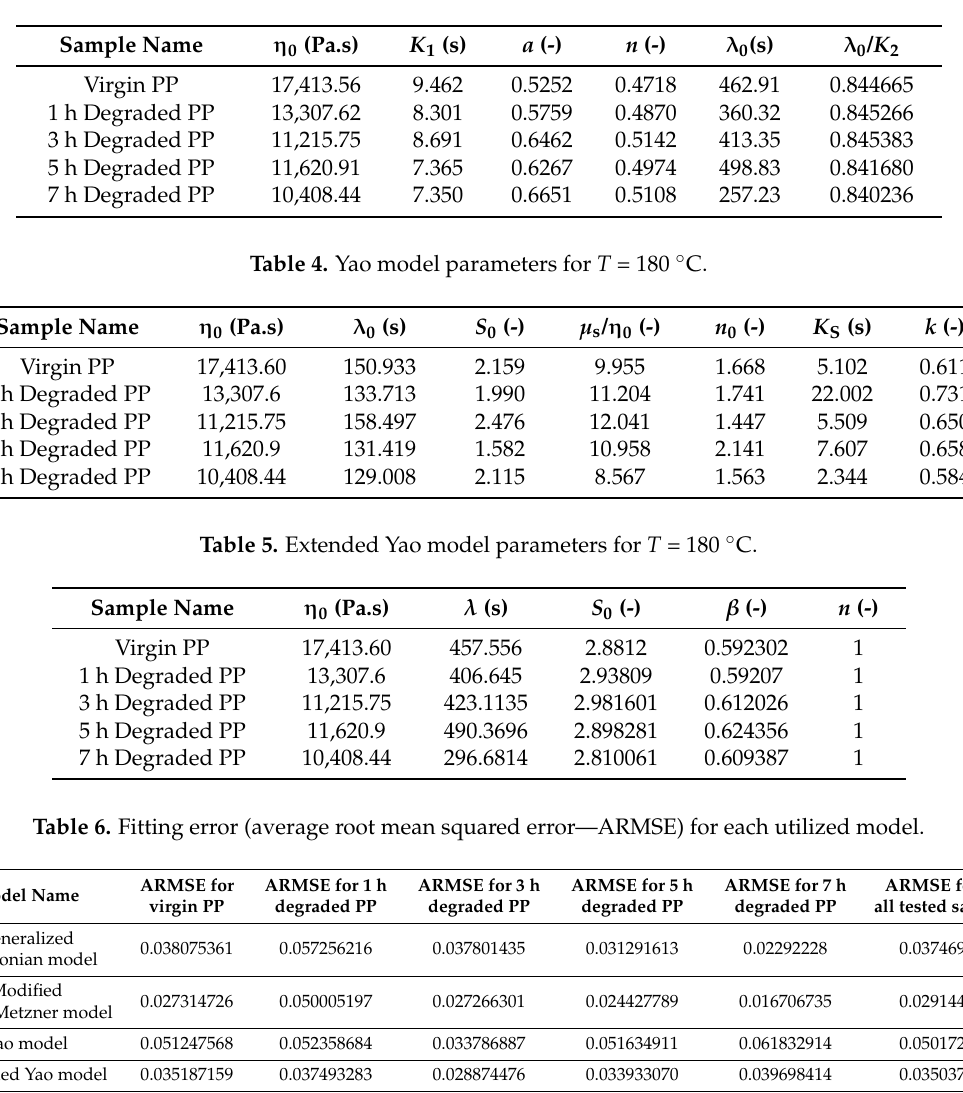
Table 3. Modified White-Metzner model parameters for T = 180 ◦ C.